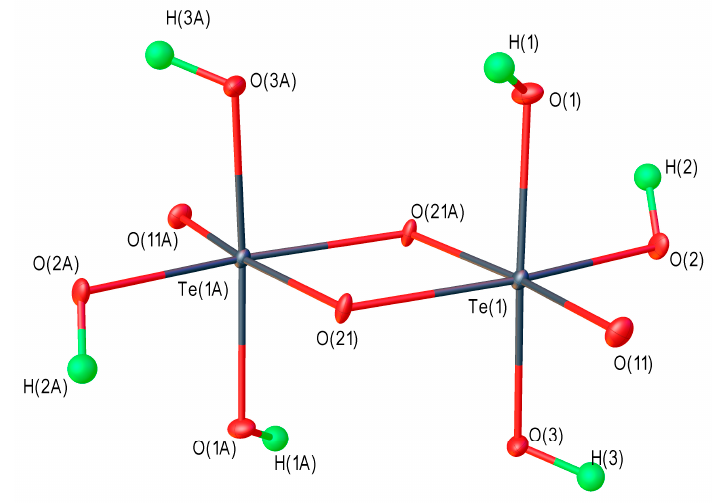
2 − anion in compound I .